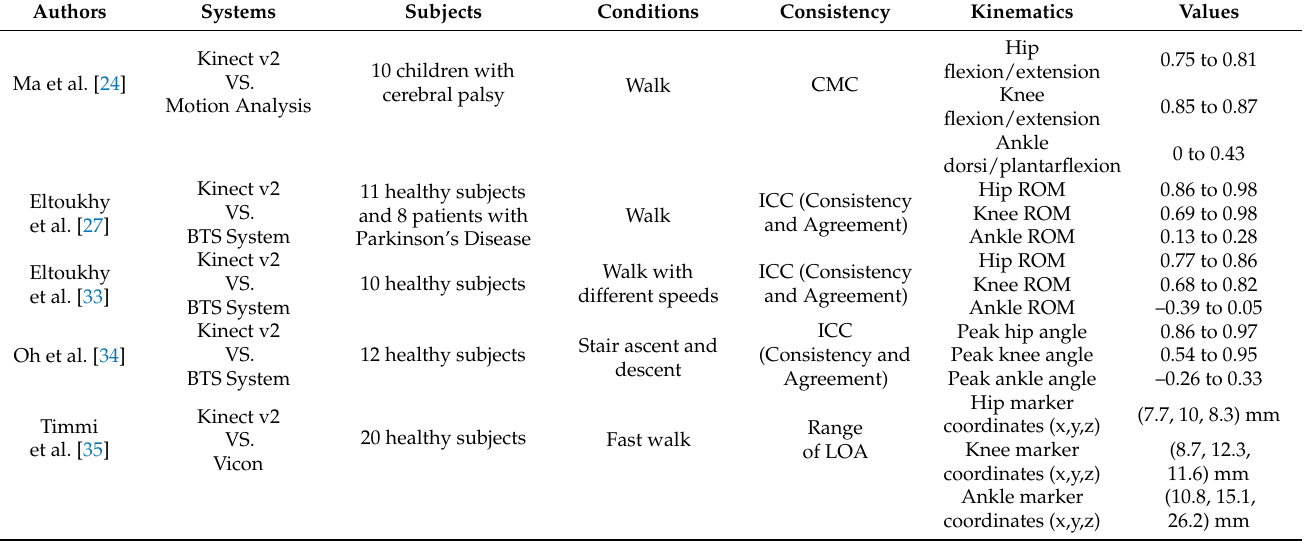
Table 3. The validation of some gait analysis systems based on depth camera for measuring kinematics compared with conventional optical 3D gait analysis systems in the